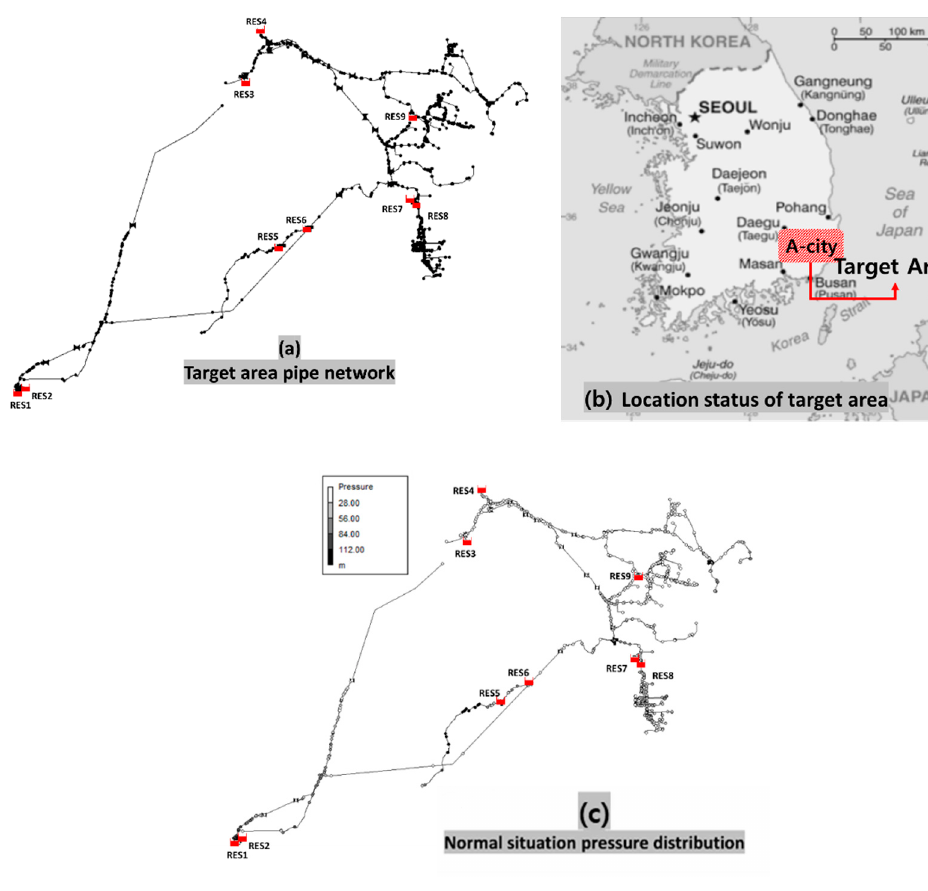
Figure 3. Pipe Network in the Target Area.